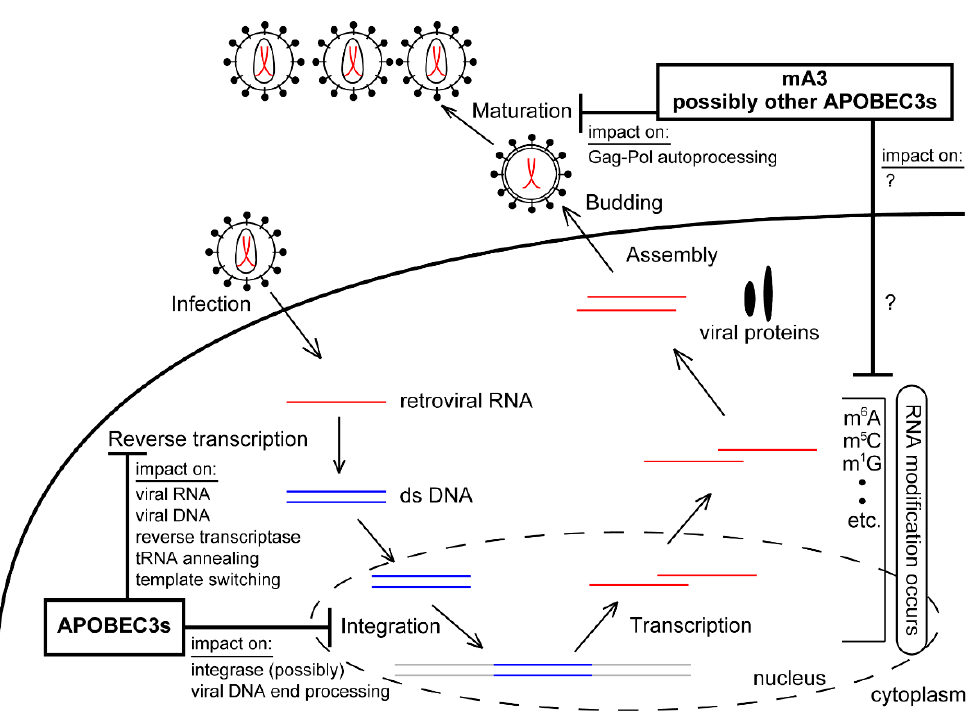
Figure 2. Deaminase-independent antiretroviral function of APOBEC3s. APOBEC3s inhibit the steps of the retroviral life cycle such as reverse transcription, integration, maturation (Gag-Pol autoprocessing), and possibly viral RNA modification in a deaminase-independent manner.